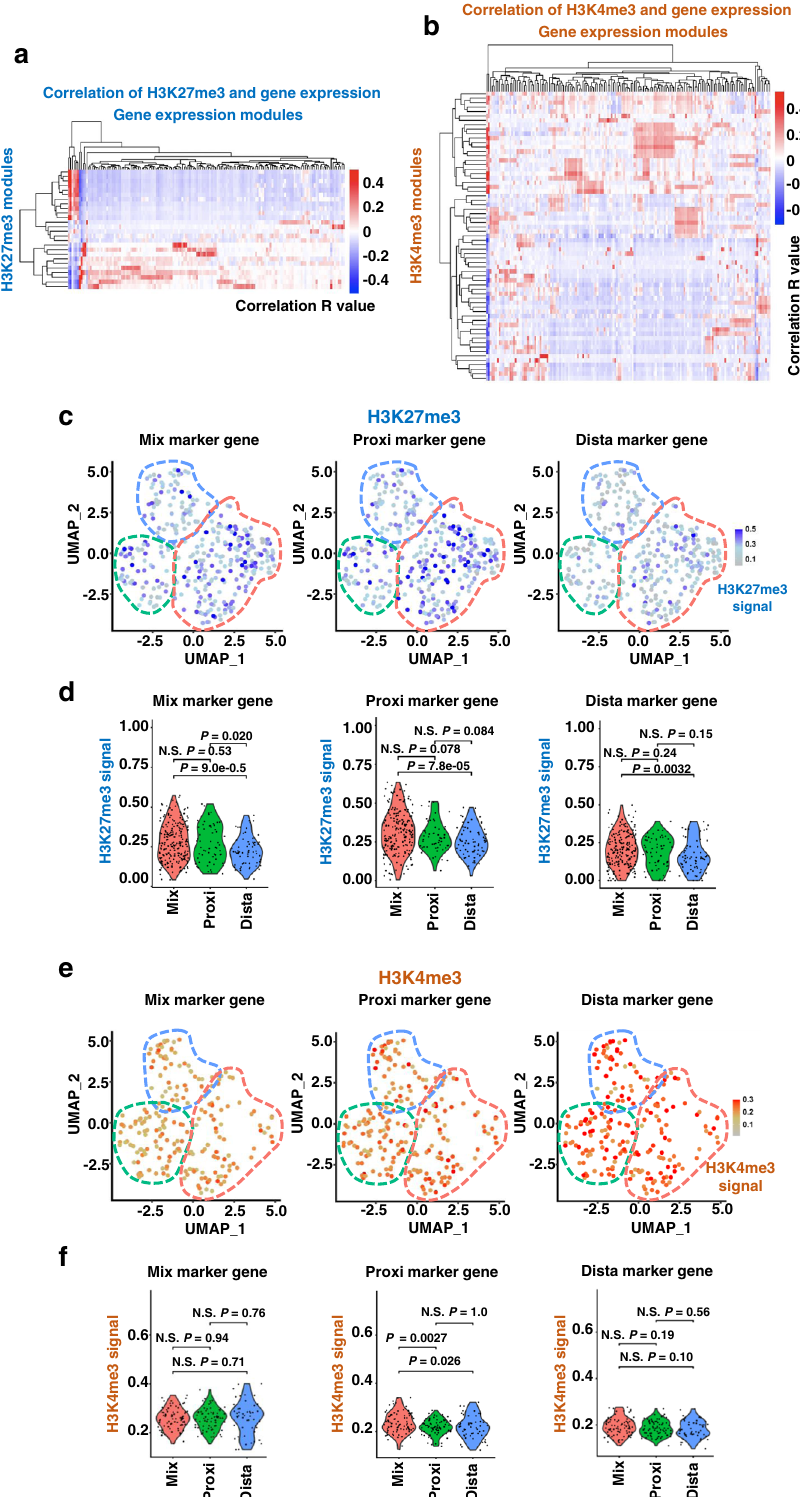
cluster cells at average expression levels, consistent with the observation of high H3K27me3 signals at marker genes in Mix cluster cells (Fig. 6a). Conversely, Jarid2 , Eed and Rbbp4 were expressed at high levels in cells from both the Proxi and Dista clusters. Ezh2 and Suz12 were upregulated in cells of the Dista cluster. Notably, Rbbp7 was not detected using scSET-seq.